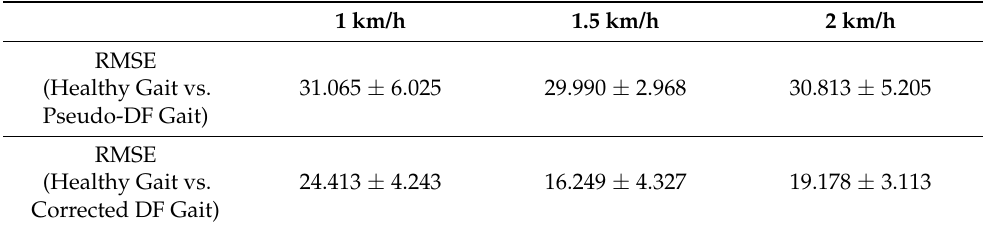
Table 4. RMSE values obtained by comparing healthy gait cycles with the pseudo-DF and the corrected DF gait cycles for three walking speeds.